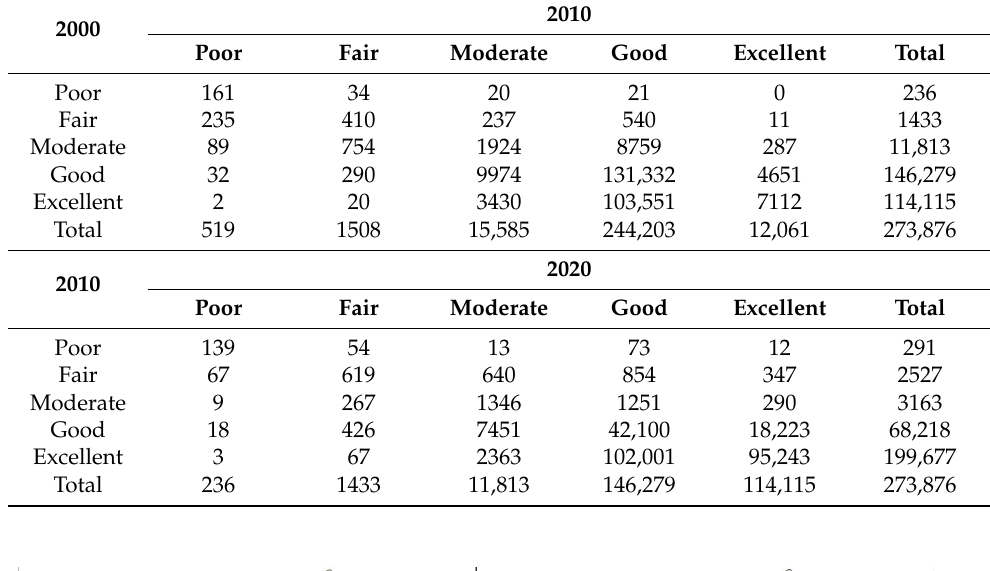
Table 4. RSEI transfer matrix in Huaibei City during 2000–2020. (unit: km 2 ).